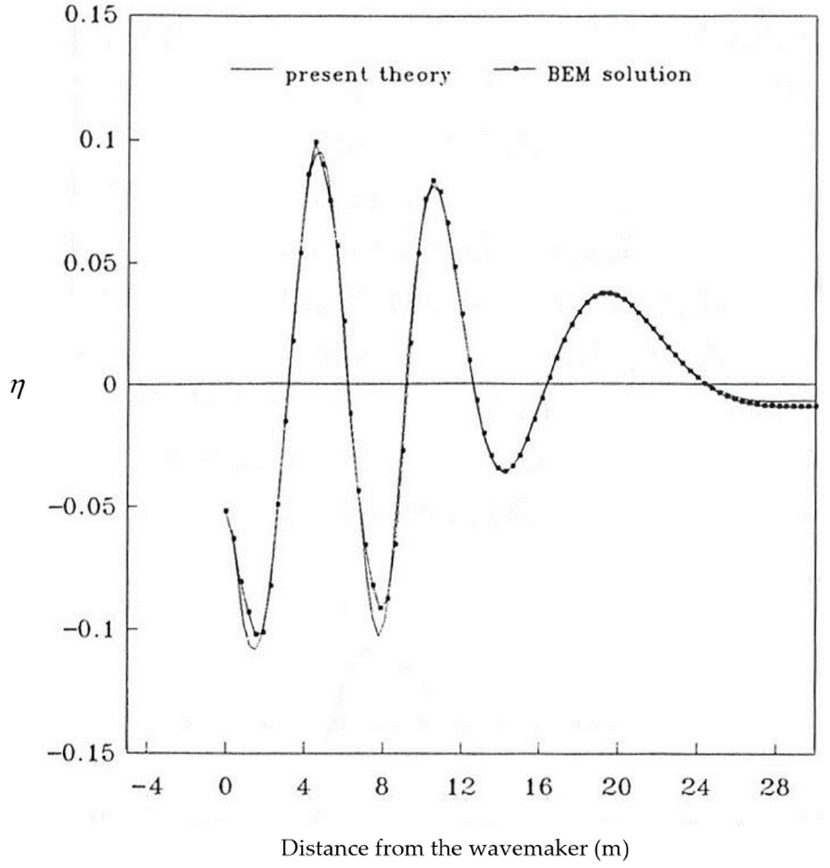
Figure 6. Comparison of free surface elevation between analytical solution and numerical solution (cited from Figure 13, Lee [15]).